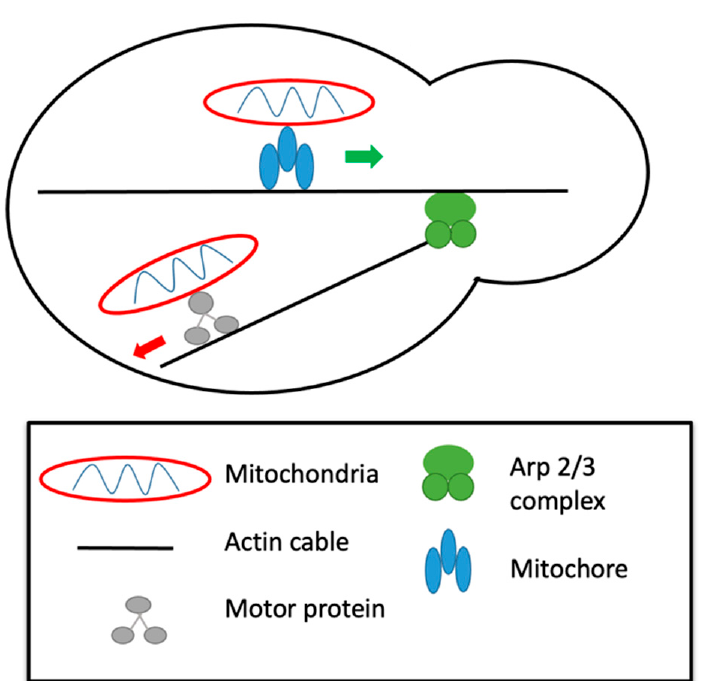
Figure 3. Model of two potential mechanisms of motility in budding yeast. It is thought that anterograde moving mitochondria travel along actin by attaching via the mitochore (top). It is also thought that motor proteins may be the point of attachment for mitochondria to actin filaments (bottom).